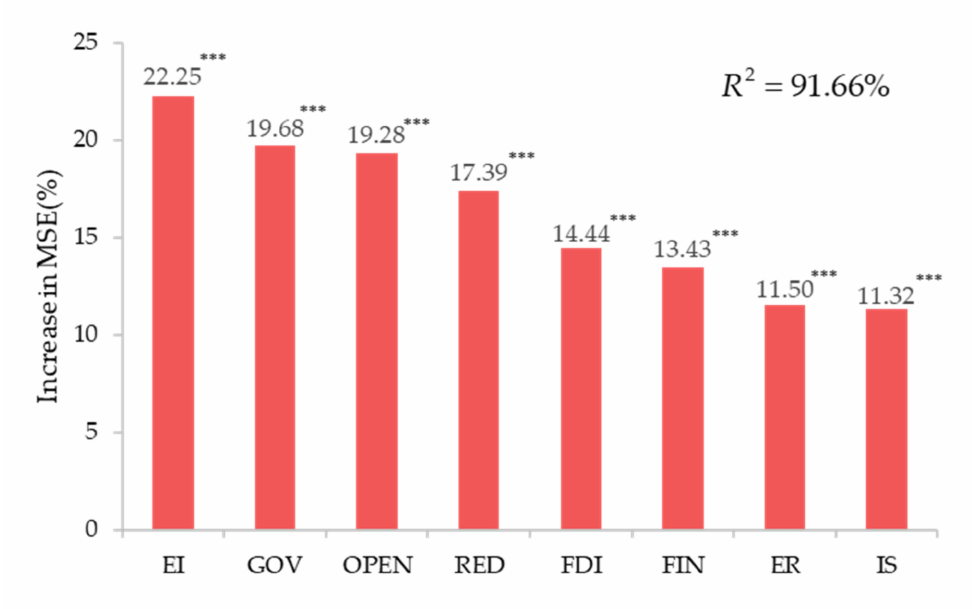
Figure 7. Importance and significance of each variable. Note: *** Significant at